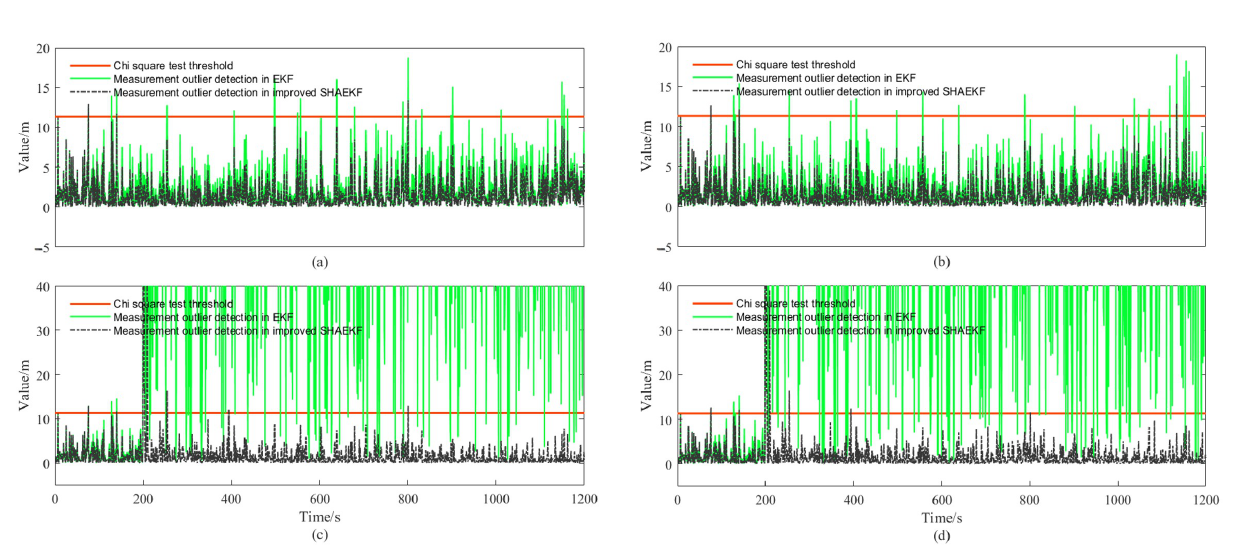
Figure 6. Detection of abnormal measurement. ( a , c ) Description of the results of AUVs that moved along a straight line at a uniform constant speed; ( b , d ) description of the results of AUVs that moved along a curve at a uniform constant